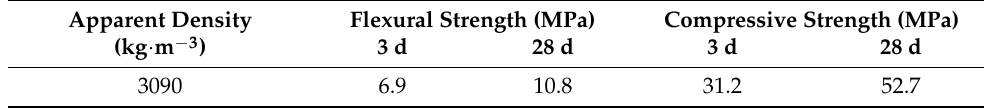
Table 2. Primary technical indices of Portland cement.